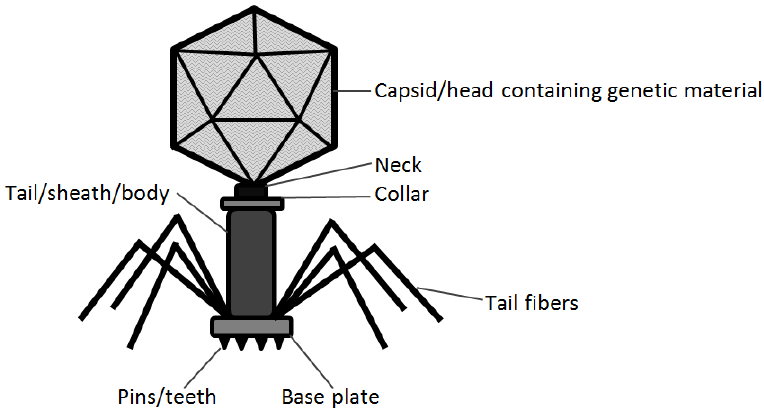
Figure 1. The anatomy of a tailed bacteriophage of the order Caudovirales .